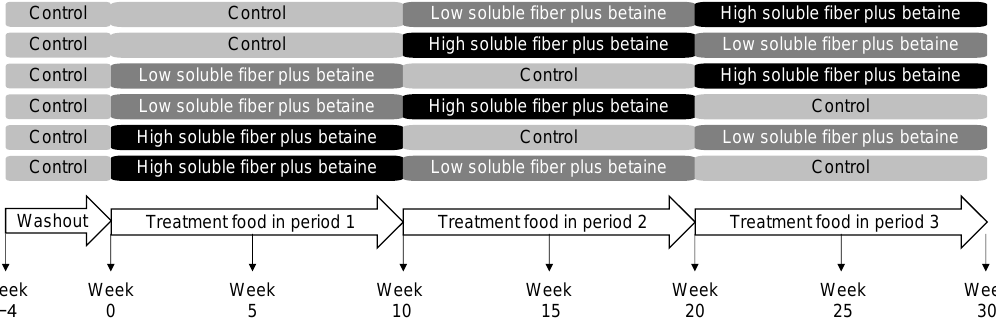
Figure 5. Study design and timeline in which dogs consumed the control, low soluble fiber plus betaine, and high soluble fiber plus betaine foods in a Williams Latin Square sequence.